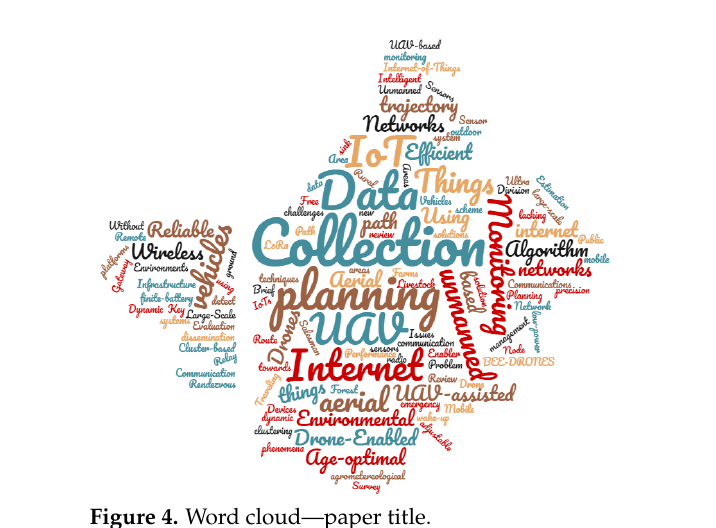
Figure 4. Word cloud—paper